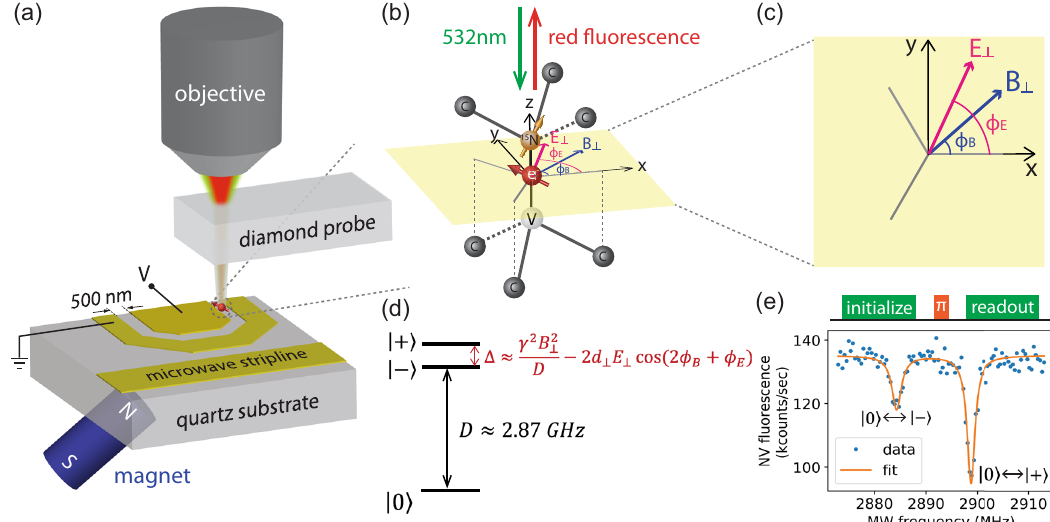
Fig. 1 Experimental setup and NV center. a Schematic of the experimental apparatus showing the confocal objective lens, a diamond probe, a U-shaped gold structure and microwave stripline fabricated on a quartz substrate, and an external magnet. The NV center is located at the apex of the diamond tip at a depth of ~40 nm. The tip has a diameter of 300 nm and hovers above the sample. The NV-sample distance is typically ≲ 100 nm. The gap between the two electrodes is 500 nm, and Au is (150 ± 5) nm thick. b NV center in the presence of a perpendicular magnetic fi eld, denoted by B ⊥ in the XY plane in yellow. The ^ x direction is de fi ned by the projection of one of the carbon atoms. E ⊥ is the electric fi eld component in the XY plane, which causes Stark shifts of the NV spin states. ϕ B and ϕ E denote the azimuth angle of B ⊥ and E ⊥ relative to the ^ x -axis. c Zoom-in of the XY plane. Gray lines represent the projections of carbon atoms. d NV electron spin energy level under B ⊥ . The ± j i states are superpositions of m S ¼ ±1 j i (see main text) and sensitive to E ⊥ . d ⊥ = (0.17 ± 0.03) MHz/V/ μ m is the transverse electric fi eld coupling constant and γ = 2.8 MHz G − 1 is the electron spin gyromagnetic ratio. e Top panel: optical and microwave sequence for pulsed optically detected magnetic resonance (ODMR) measurements. Bottom panel: Pulsed ODMR spectrum showing transitions between 0 j i and ± j i under B ⊥ ≈ 73 G. The driving ef fi ciencies depend on the MW fi eld polarization. The 0 j i -to- þj i transition is used throughout this work for electric fi eld